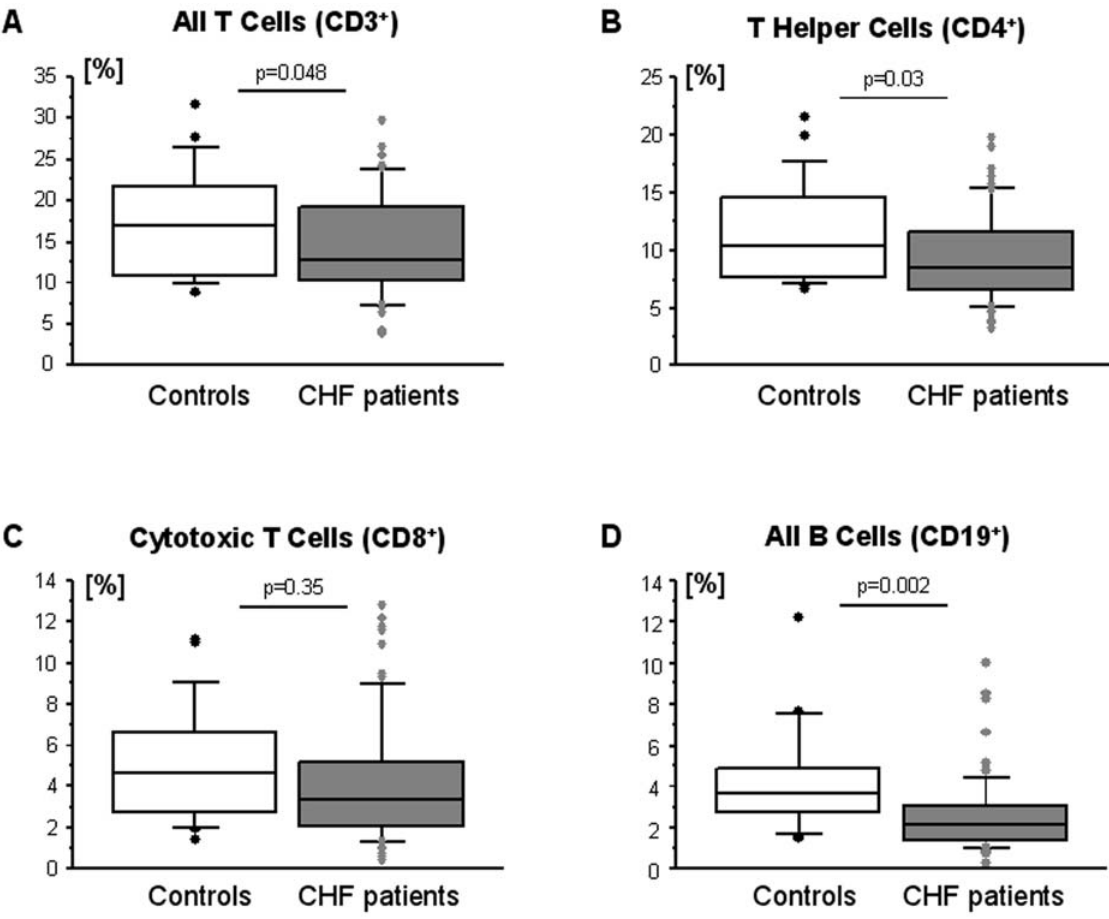
Figure 3. Distribution of lymphocyte subsets in healthy control subjects (n=20) and patients with CHF (n=75).